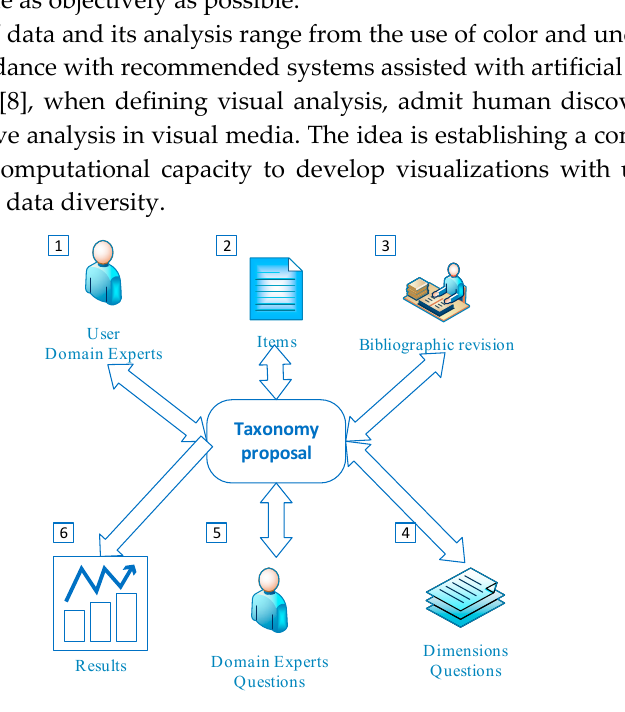
Figure 1. Scheme phases of the